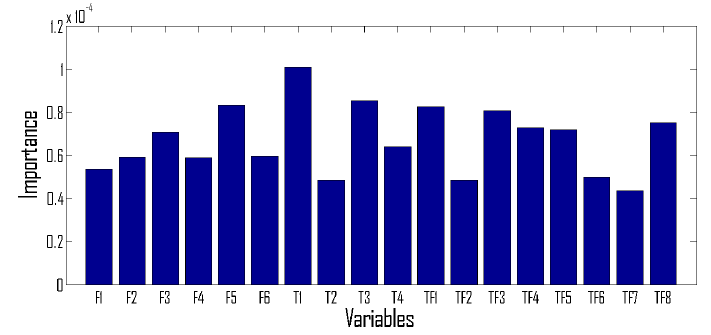
Figure 10. Importance of each feature. Note that F 1 , F 2 , F 3 , F 4 , and F 5 are modified frequency marginal features described in Table 1. T 1 , T 2 , T 3 , and T 4 are modified time-marginal features described in Equation 2. TF 1 , TF 2 , ... TF 8 are TF features defined in Table